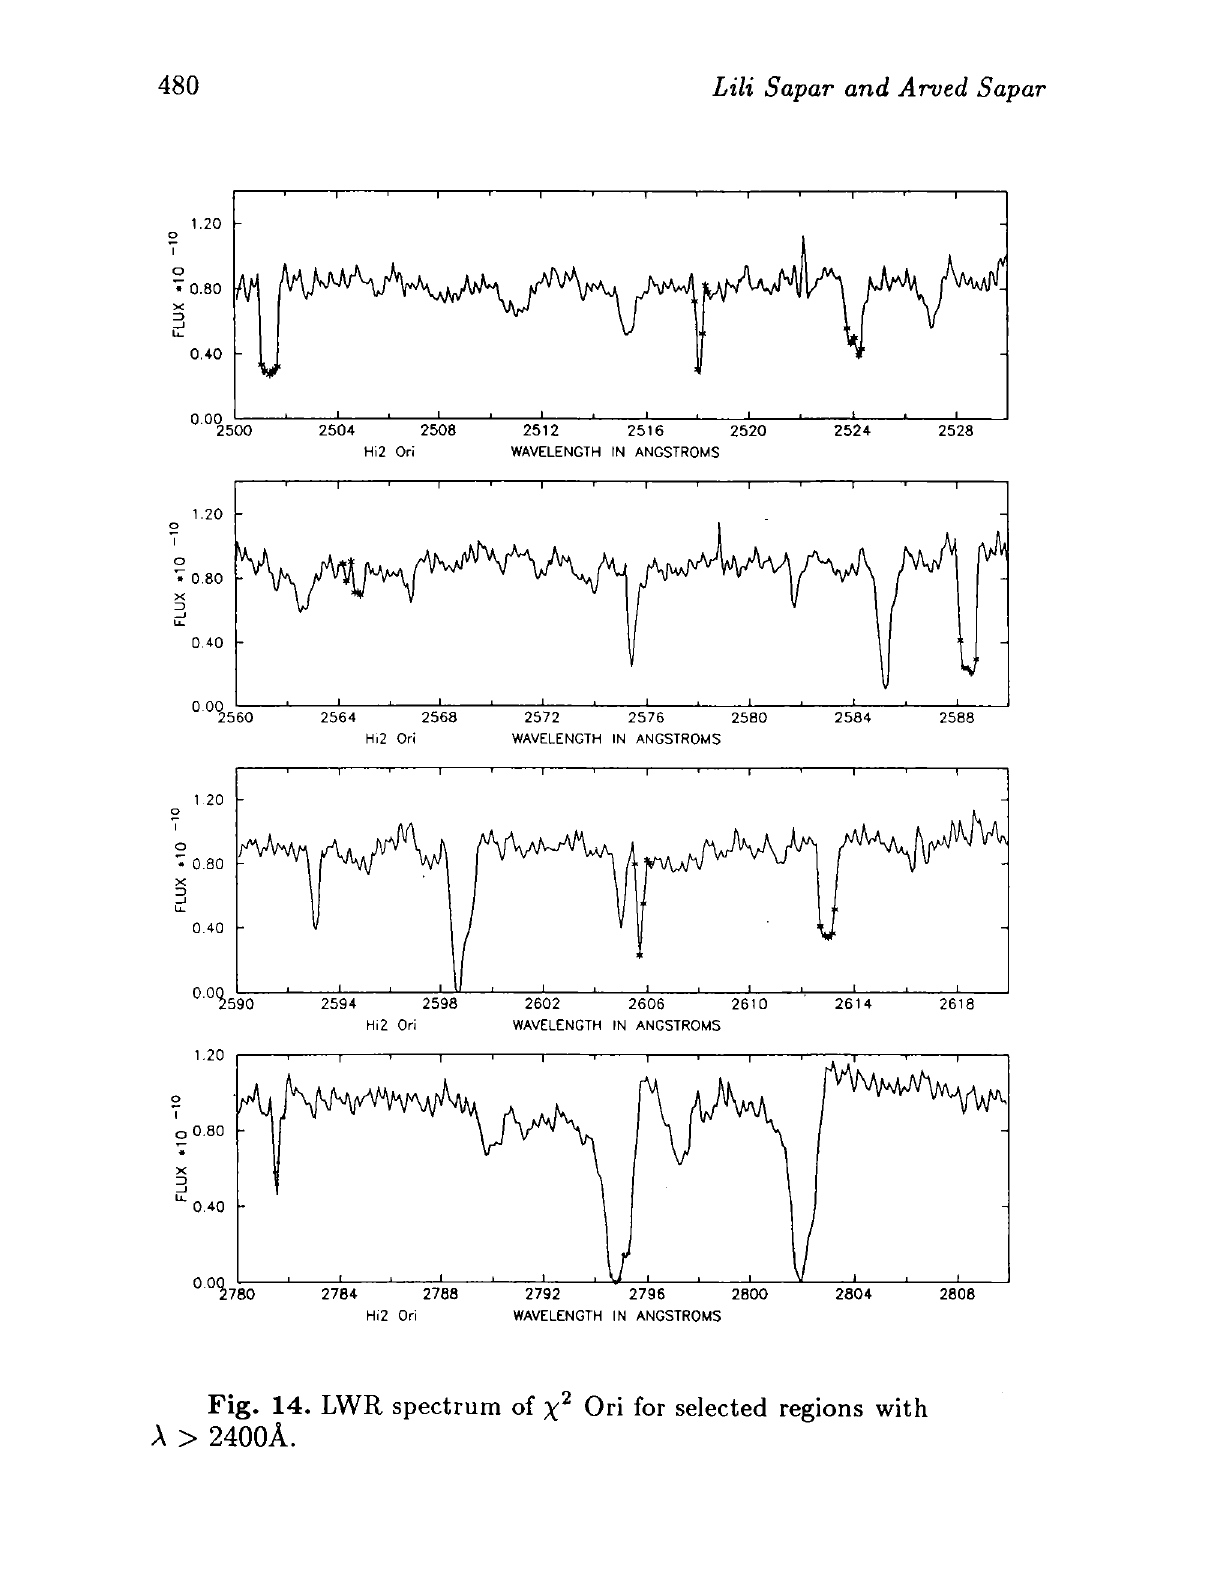
Fig. 14. LWR spectrum of x 2 Ori for selected regions with A >